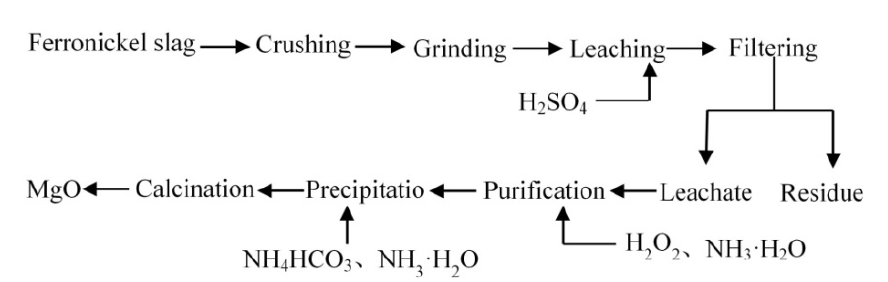
Figure 2. Process flow of recovering Mg from FNS to prepare MgO.